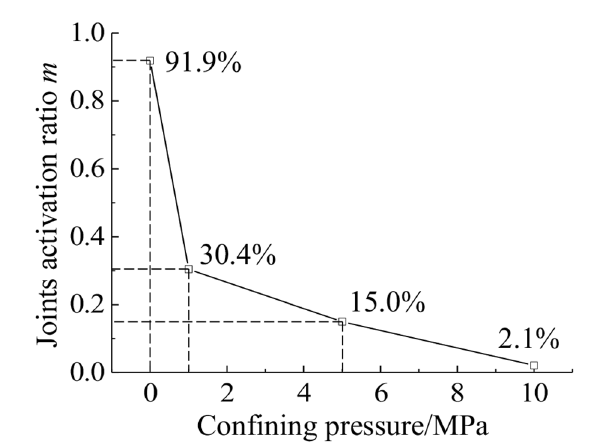
Fig. 17 Joints activation ratio of jointed coal subjected to triaxial com - pression with different confining